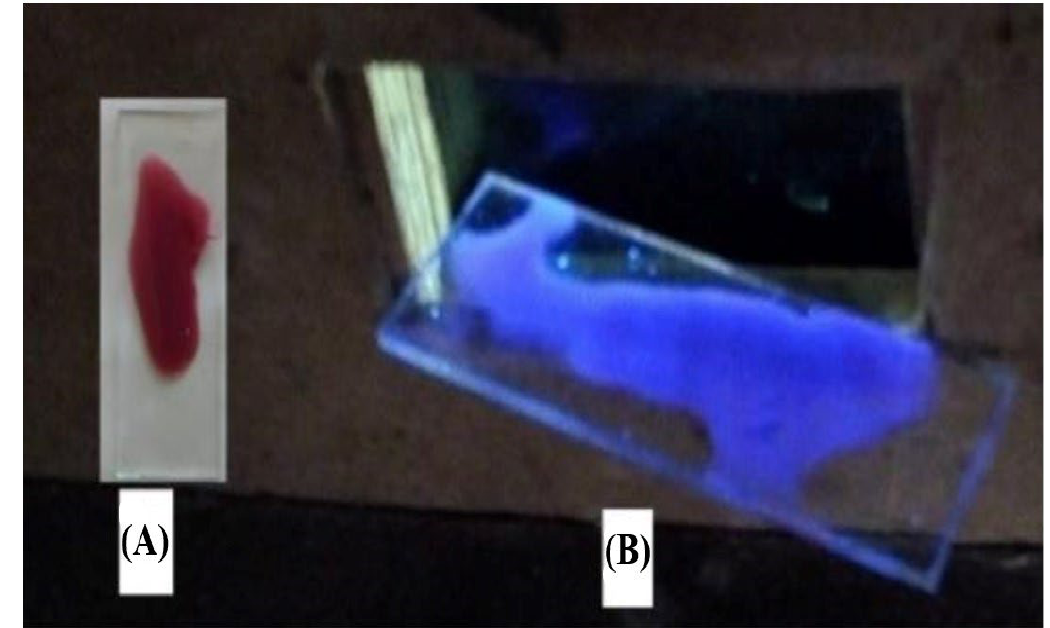
Figure 6. Appearance of the SPE product of CR: ( A )—in daylight and ( B )— in ultraviolet light (λ = 385 nm).